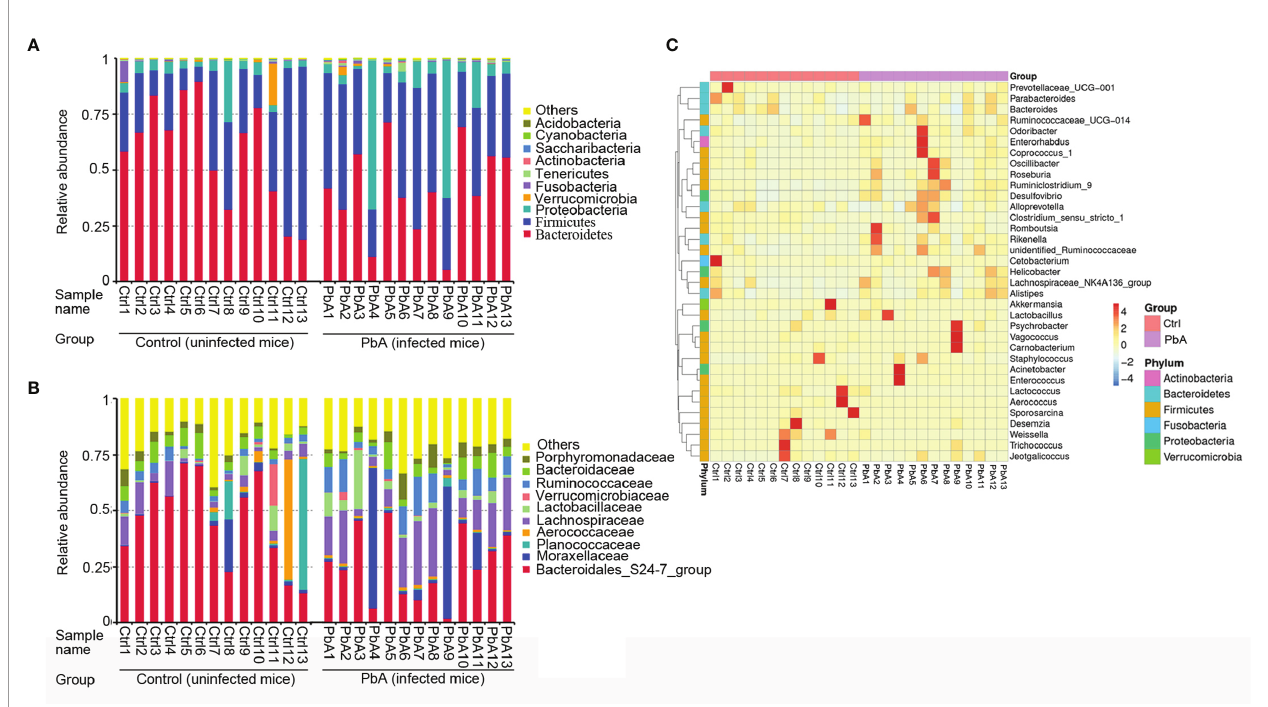
FIGURE 3 | Changes in the microbial community components. Relative abundance of fecal bacterial phyla and families existing in C57BL/6 mice. Each bar represents the top 10 most abundant phyla and families, whereas “ Other ” was obtained from low abundance and unclassi fi ed OTUs. Sample names represent the samples described in Table 1 . (A) Variations in the bacterial community components at the phylum level. (B) Variations in the bacterial community components at the family level. (C) Taxonomic heatmap of the two groups at the genus level. Typical relative abundance of diversi fi ed genera present in the Ctrl and PbA groups. Each column represents a unique